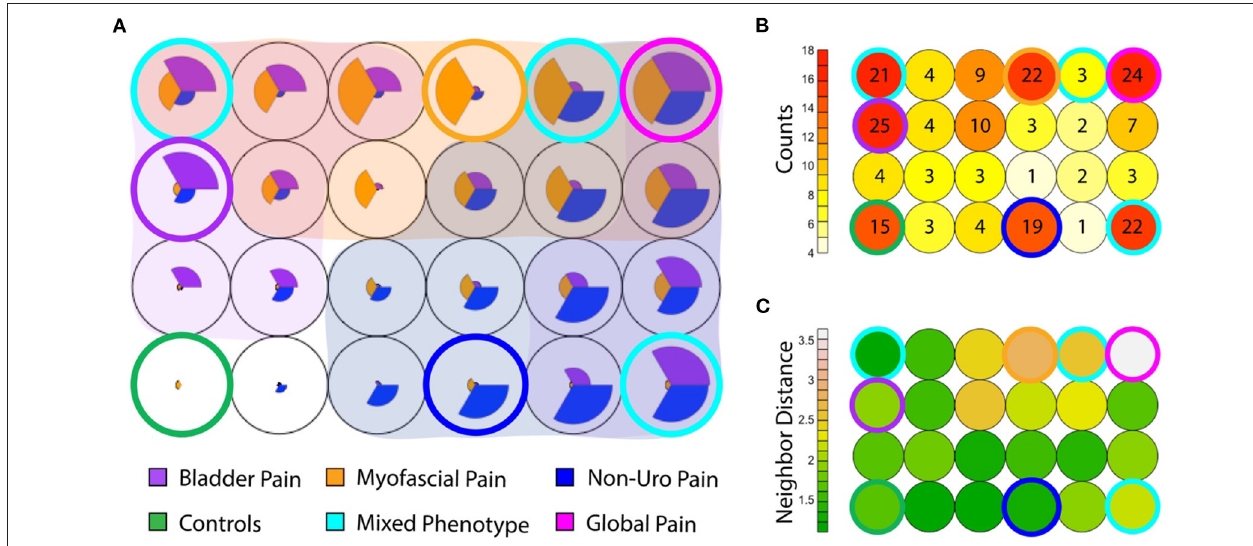
FIGURE 6 | Coexisting symptom domains determined by Kohonen self-organizing map (SOM). (A) The SOM groups subjects (including IC/BPS subjects and asymptomatic controls) into 24 (6 × 4) bins. Within each, the size of each pie slice expresses the average measure score for that subgroup after scaling to normalize values. Asymptomatic controls are at the inferior left corner (green ring), in which no pie slices are seen. The canonical phenotypes, expressing only a single symptom cluster are ringed in blue for NUPP, orange for MFP, and purple for BPS. Other combinations of phenotypes are shaded by an overlay of the respective group color when that symptom profile was expressed within that group. The most common mixed phenotypes are ringed in cyan. The global pain phenotype, in which all three symptom types were highly expressed, is ringed in magenta. (B) The numbers of patients within each of the groups in A are expressed in a heat map, with the relative position of each bin corresponding to the layout seen in (A) . The number indicates the absolute number of subjects in each bin. Most subjects reside in the control and the ringed phenotypic groups, with a substantial minority present in subgroups expressing more than one phenotype. (C) The similarity of each of the symptom patterns to the neighboring bin in Euclidean distance is expressed as a heat map (each bin shading from green to white). For example, the MFP phenotype ringed in orange is highly dissimilar to the surrounding symptom combinations, but the global pain phenotype ringed in magenta is the most dissimilar from all other groups, demonstrating the largest Euclidean distance to its neighbors.